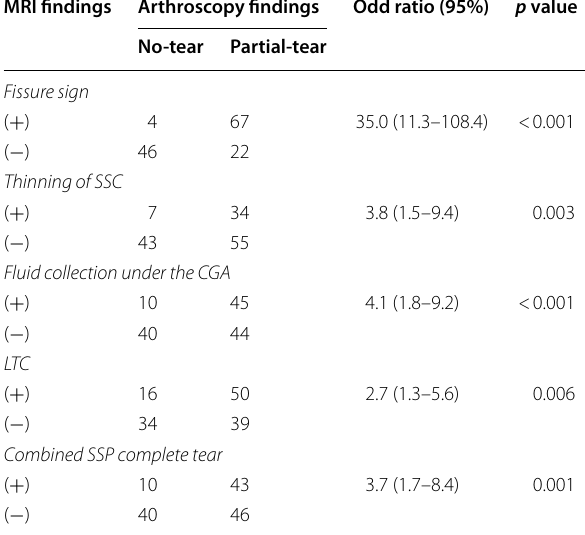
Table 3 Numbers of patients in the control group (no-tear group) and case group (partial tear group) based on MRI findings compared to the gold standard (arthroscopic findings)